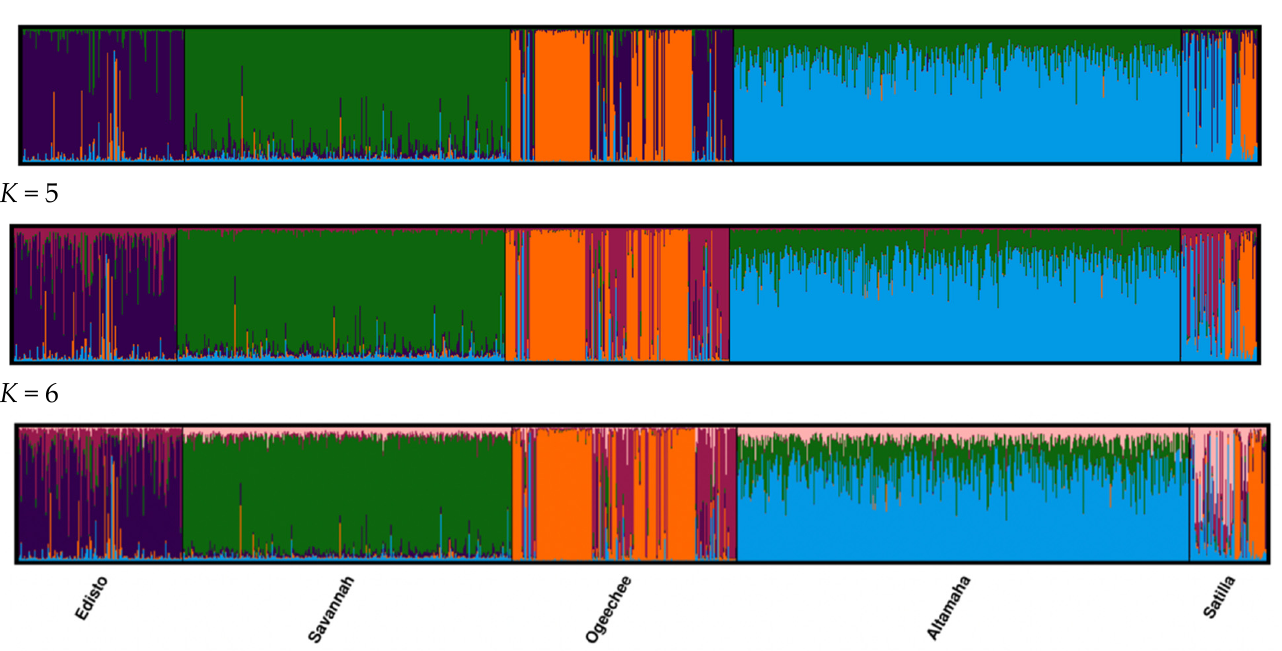
Figure 3. STRUCTURE analysis of the population structure of Atlantic sturgeon specimens from five reference populations in the South Atlantic DPS, including the Edisto, Savannah, Ogeechee, Altamaha, and Satilla rivers, based on microsatellite analysis at 11 loci. Each vertical bar represents a single individual, and different colors represent the contribution of each K genetic cluster to each specimen’s genotype. This figure depicts the results of K = four to six genetic clusters. Multiple genetic clusters ( K ) can be seen in the Ogeechee and Edisto, and Satilla river collections when K = five or six.